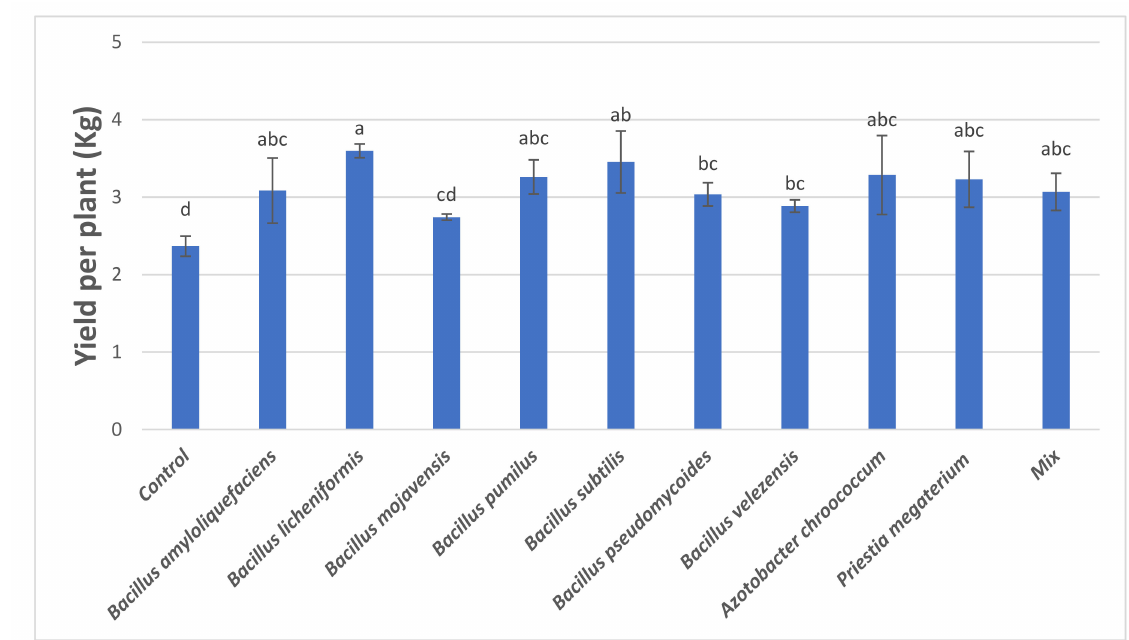
Figure 3. Mix: Mix of Priestia megaterium + Azotobacter chroococcum . Means followed by same letter for treatments are not significantly different according to Duncan test ( p < 0.05). Values presented are mean values of three replicates ± standard deviation. F value of ANOVA: 4.367 (Significance level: p <